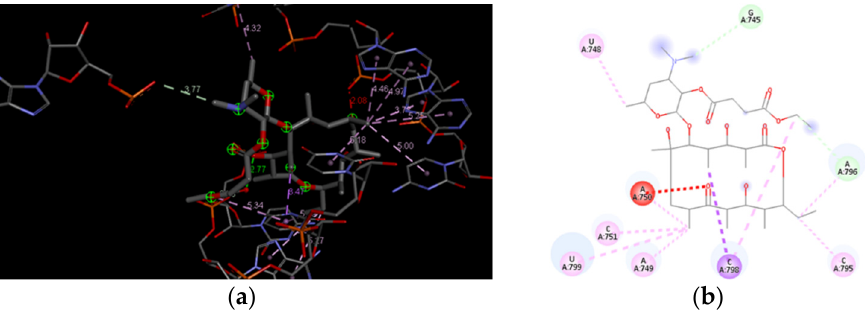
Figure 6. ( a ) Graphical representation of the obtained interactions between 5-desosaminyl erythronolide B ethyl succinate and the segment of the exit tunnel from apicoplast ribosome of P. falciparum with distances in Å; ( b ) 2D diagram of receptor–ligand interactions.